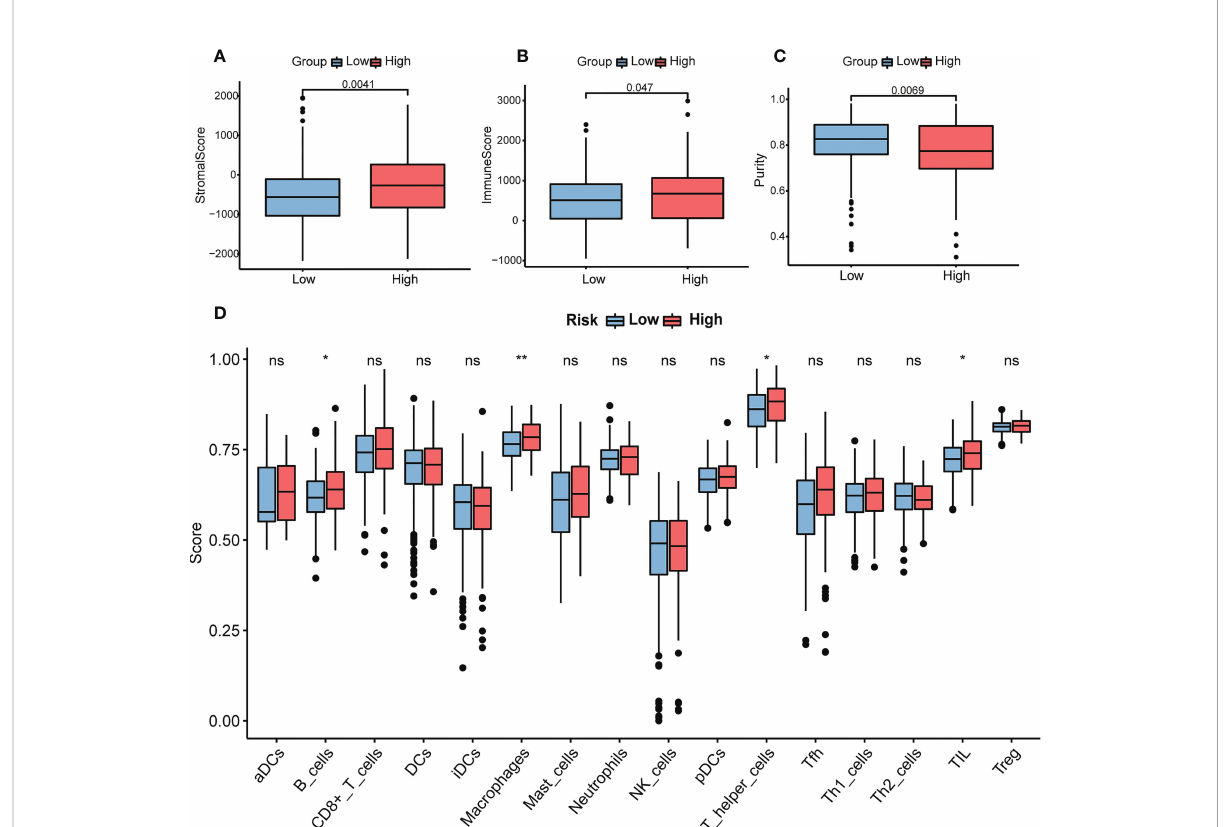
FIGURE 9 Analysis of immune in fi ltration in COAD. (A) The stromal scores in the high- and low-risk groups. (B) The immune scores in the high- and low- risk groups. (C) The purity scores in the high- and low-risk groups. (D) The content of 16 immune cells between the high- and low-risk groups. P -values were obtained using t -test. * P < 0.05, ** P < 0.01. COAD, colon adenocarcinoma. NS, no signi fi